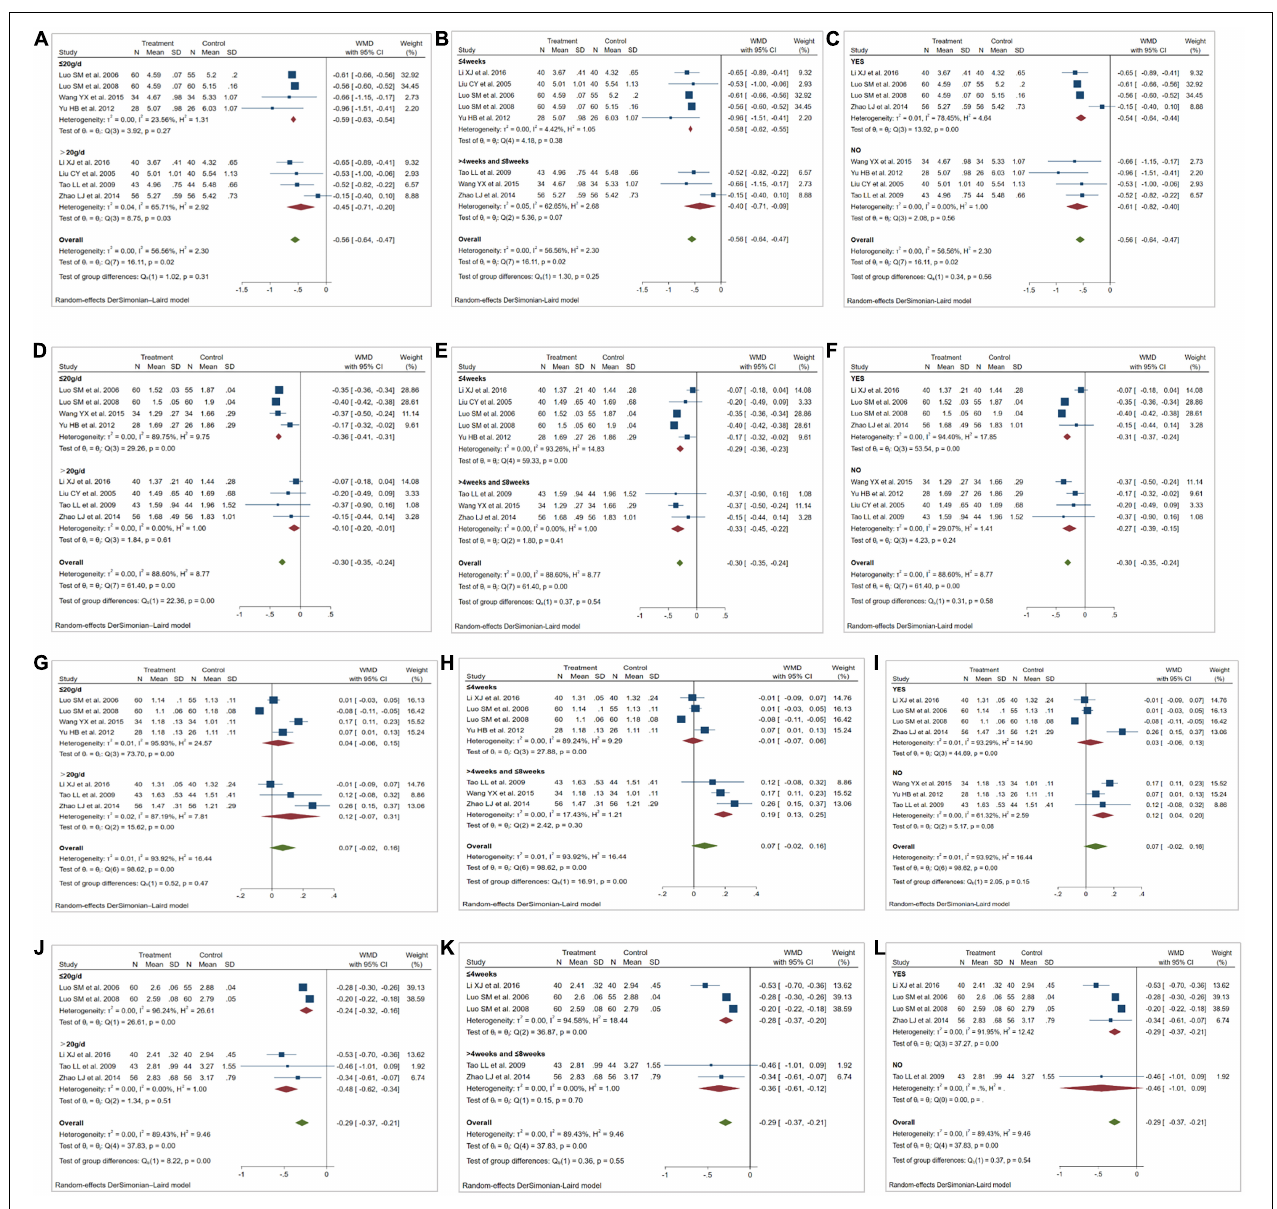
FIGURE 5 | Results of subgroup analysis. (A,D,G,J) Effect of dose of Kuding tea (KT) on total cholesterol (TC), triglyceride (TG), high-density lipoprotein cholesterol (HDL-C). low-density lipoprotein cholesterol (LDL-C). (B,E,H,K) Effect of duration of KT intervention on TC, TG, HDL-C, LDL-C. (C,F,I,L) Effect of KT use and whether statins were used in the control group on TC, TG, HDL-C, LDL-C. WMD, weighted mean